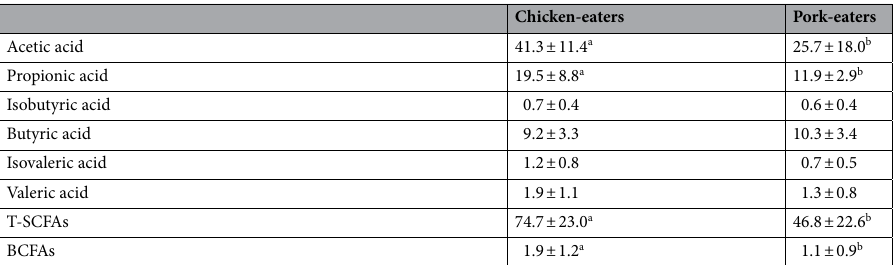
Table 1. SCFAs levels of human fecal samples (μmol/g). a,b Means differed significantly ( P <